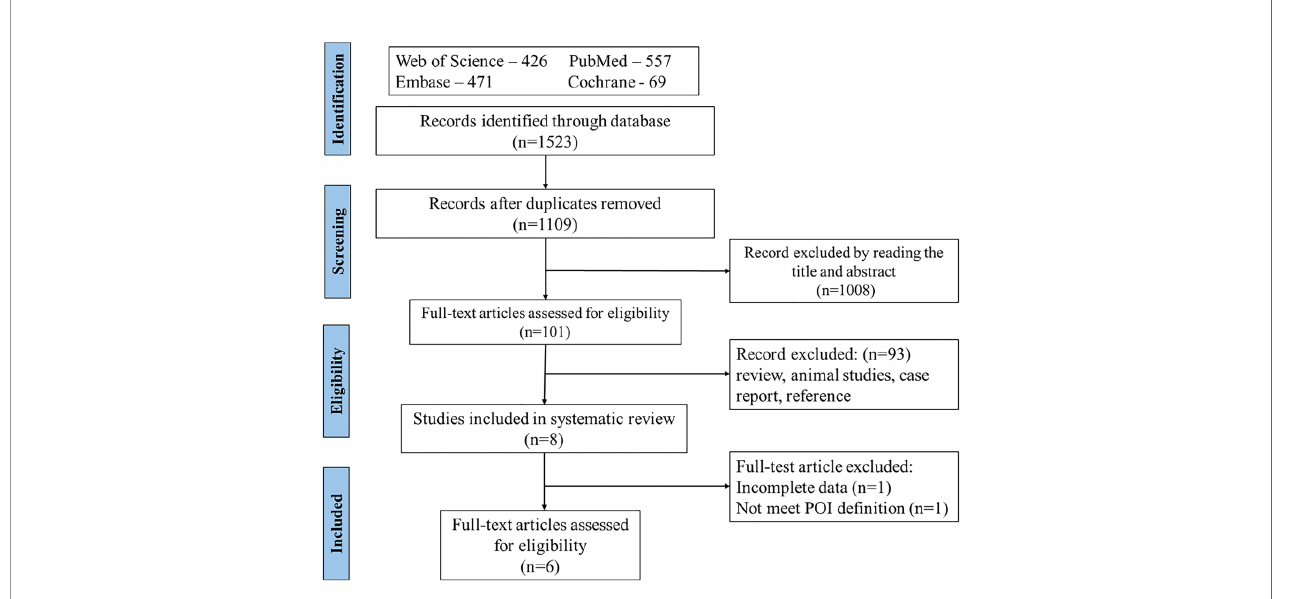
FIGURE 1 | Flow diagram of identi fi ed